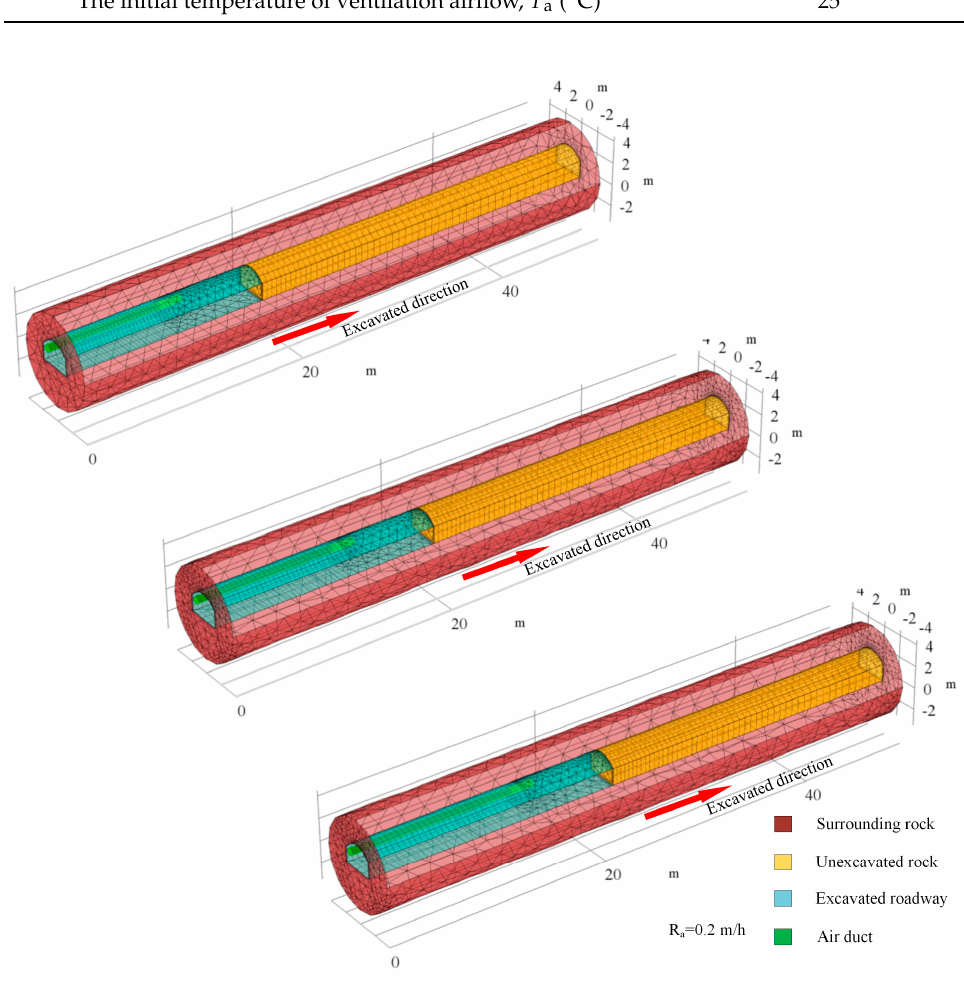
Figure 2. The moving meshes at different